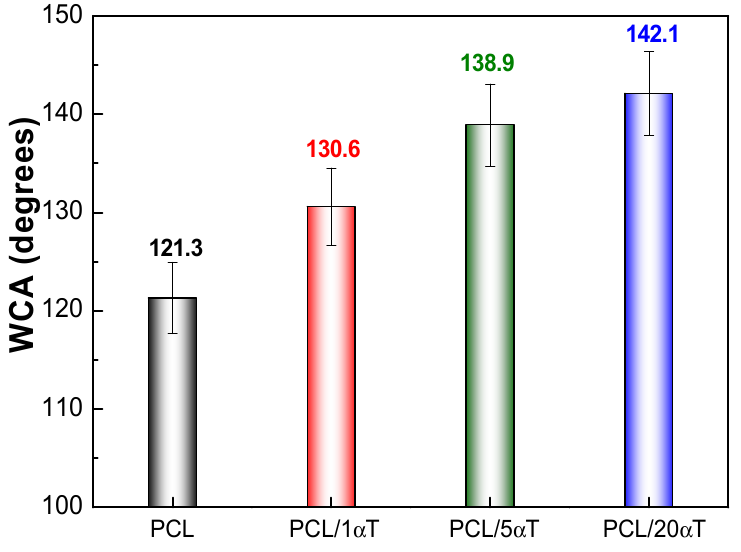
Figure 8. Water contact angle of PCL and PCL/ α T samples.